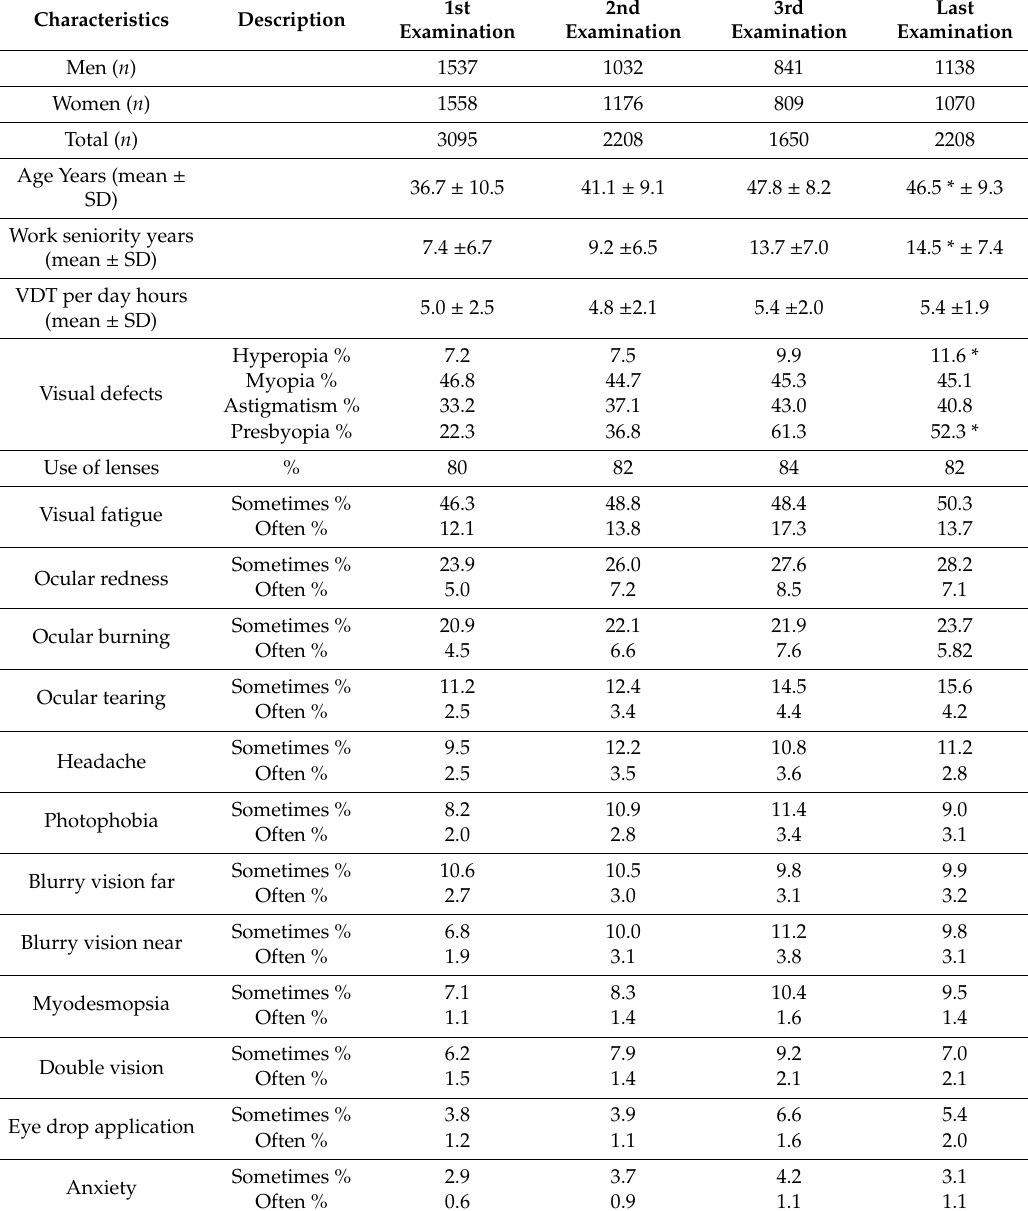
Table 1. Characteristics of participants, use of lenses and visual symptoms during the follow-up.